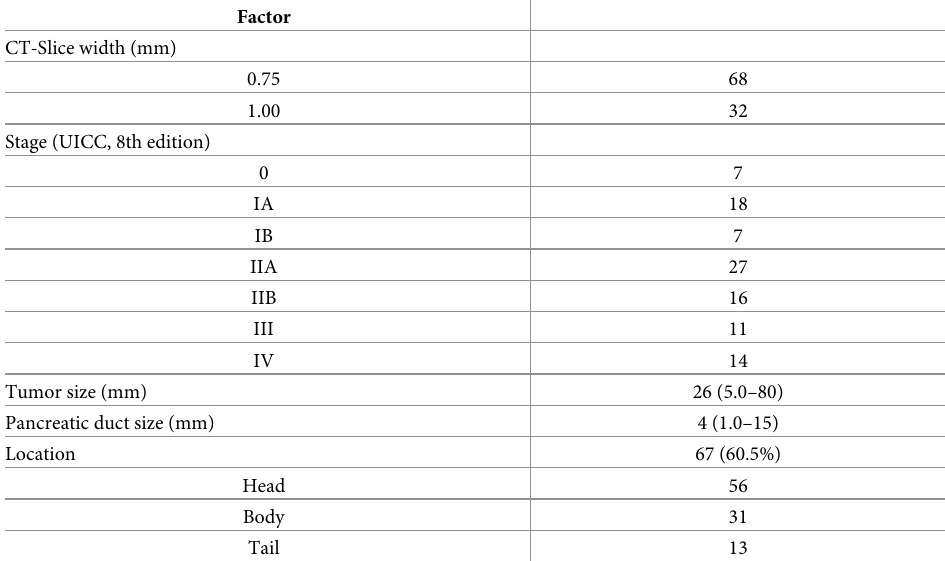
Table 1. The background characteristics of the 100 patients with pancreatic